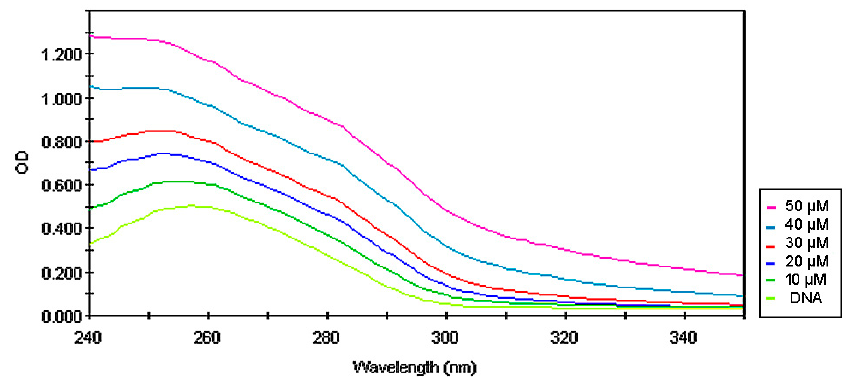
Figure 10. Absorption spectra of calf thymus DNA (250 µg/mL) in phosphate buffer (pH 7.4) upon addition of compound 1 (10, 20, 30, 40, and 50 µM, respectively).